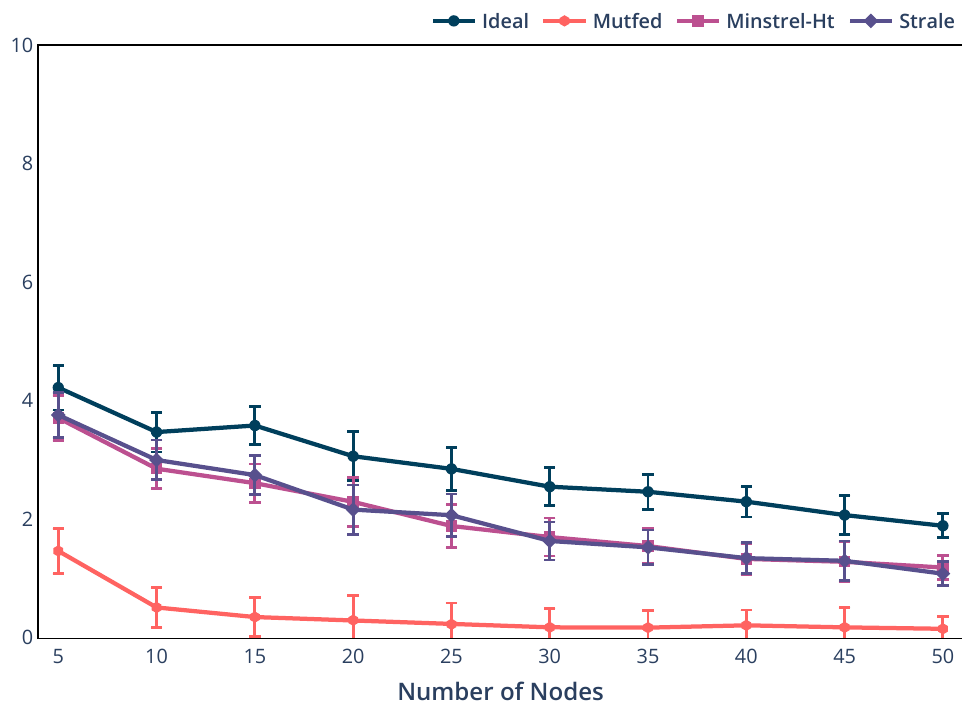
Figure 9. Mean value of the MCS selected by sender